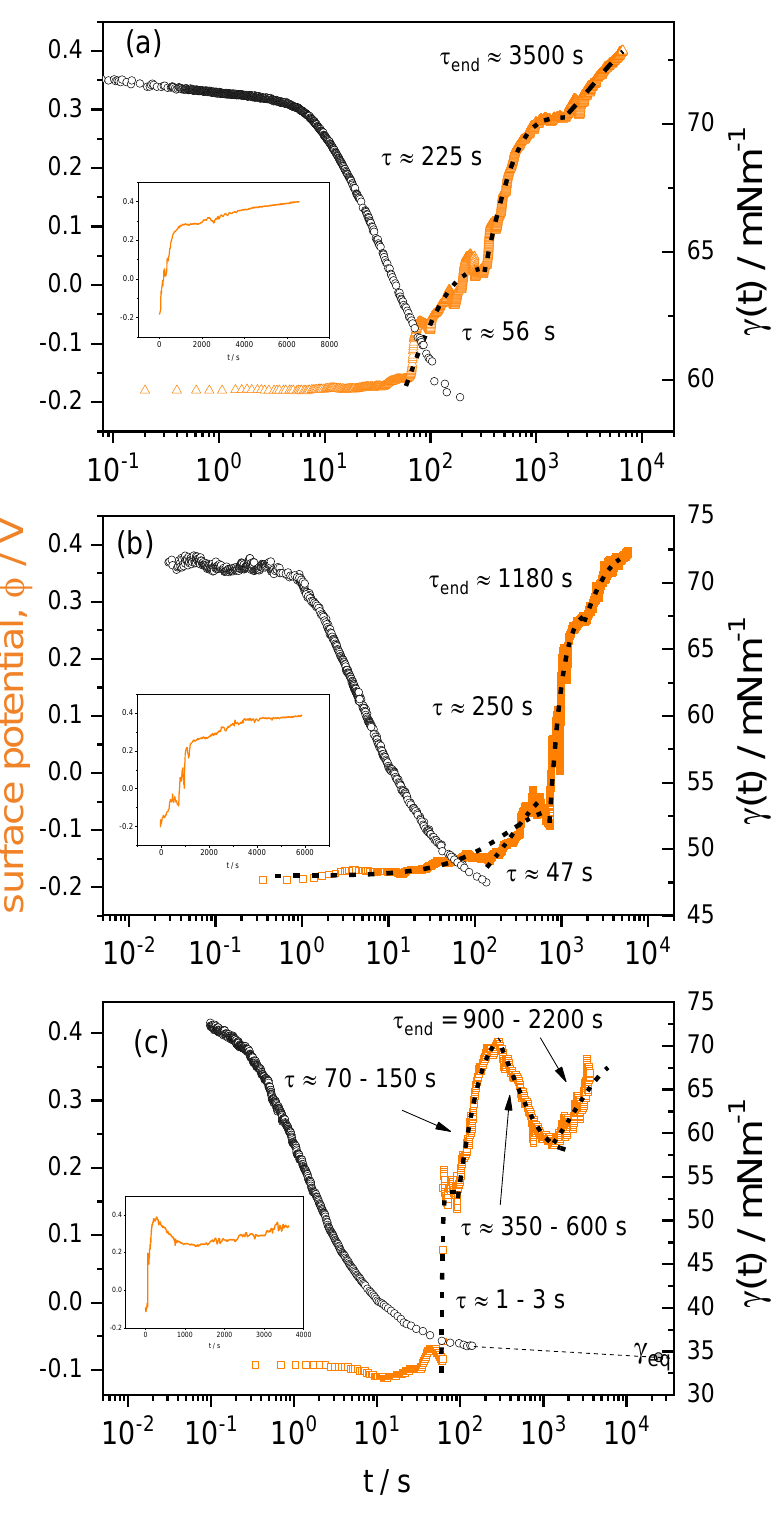
Figure 7. Time dependence of the Surface potential compared with dynamic surface tension (Surface tension in black, right axis) for three surfactant concentrations. ( a ) c s = 0.1 mM, ( b ) c s = 0.2 mM, ( c ) c s = 0.5 mM. The insets show the surface potential but with the time axis in linear scale.